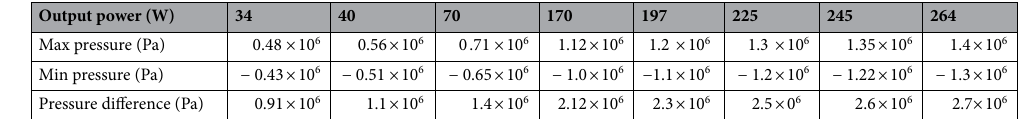
Table 2. Effect of power variation on the maximum and minimum sonicator acoustic pressures and the pressure difference.